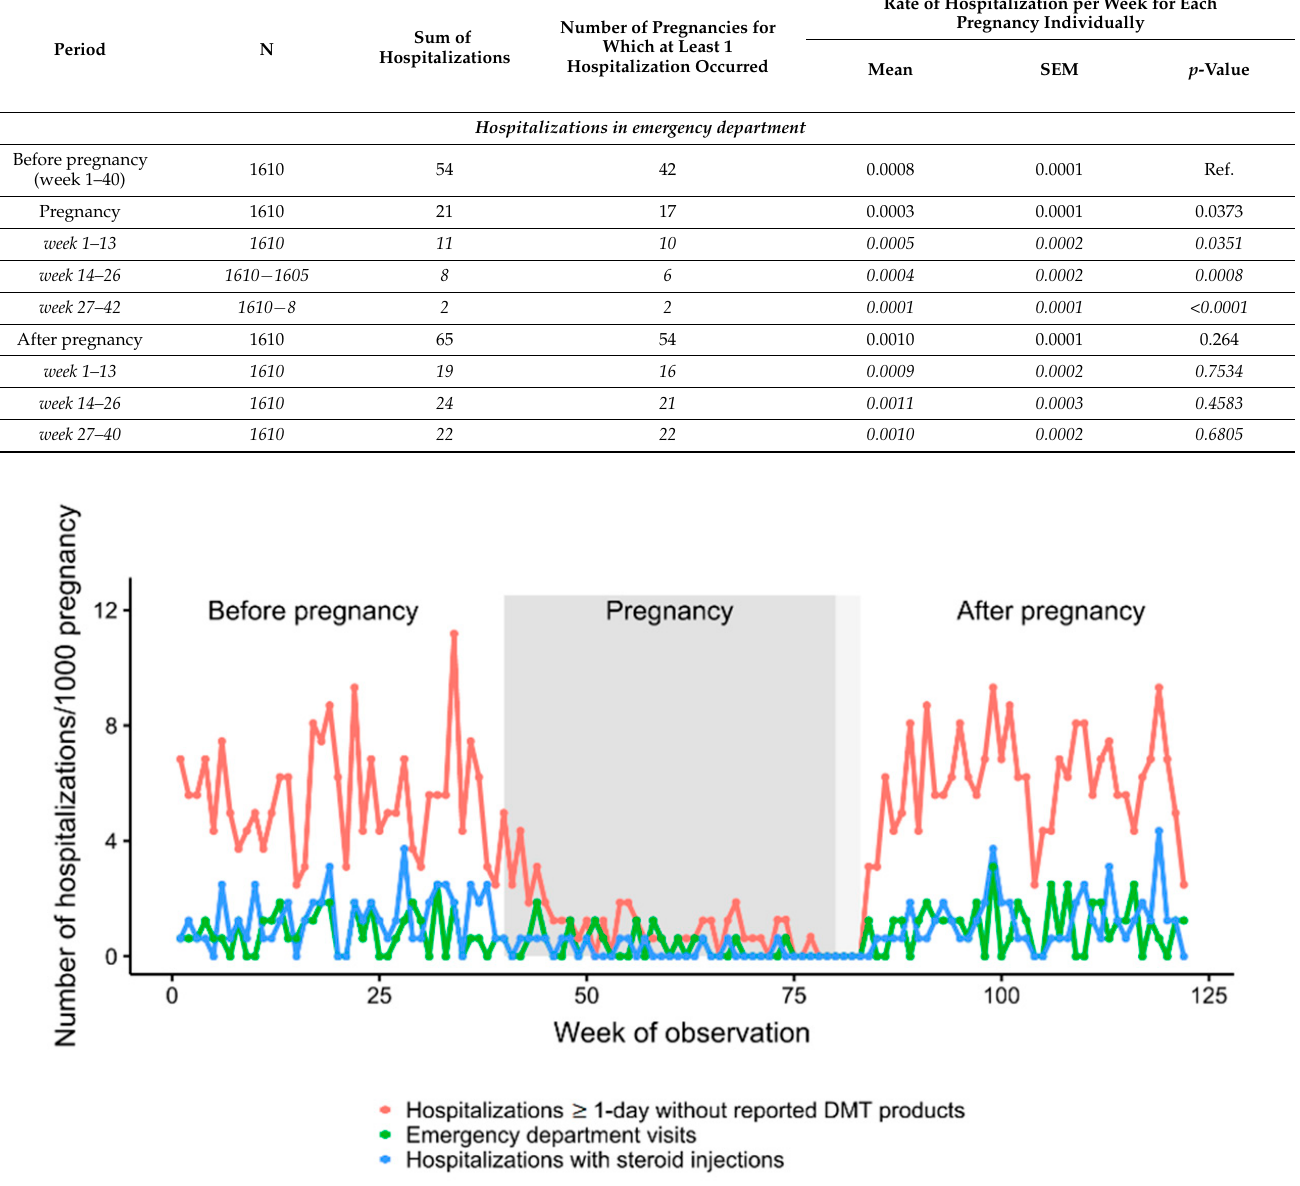
Figure 3. Weekly sums of hospitalizations of a given type per 1000 of observed pregnancies. The observation window covers 40 weeks before pregnancy, the entire gestation period (highlighted in gray) and 40 weeks postpartum. Table 3. Number of hospitalizations before, during and after pregnancy with the standard error of the mean. The weekly rate of hospitalizations for each pregnancy during and after pregnancy was compared to the rate before pregnancy using Wilcoxon tests for pairs.